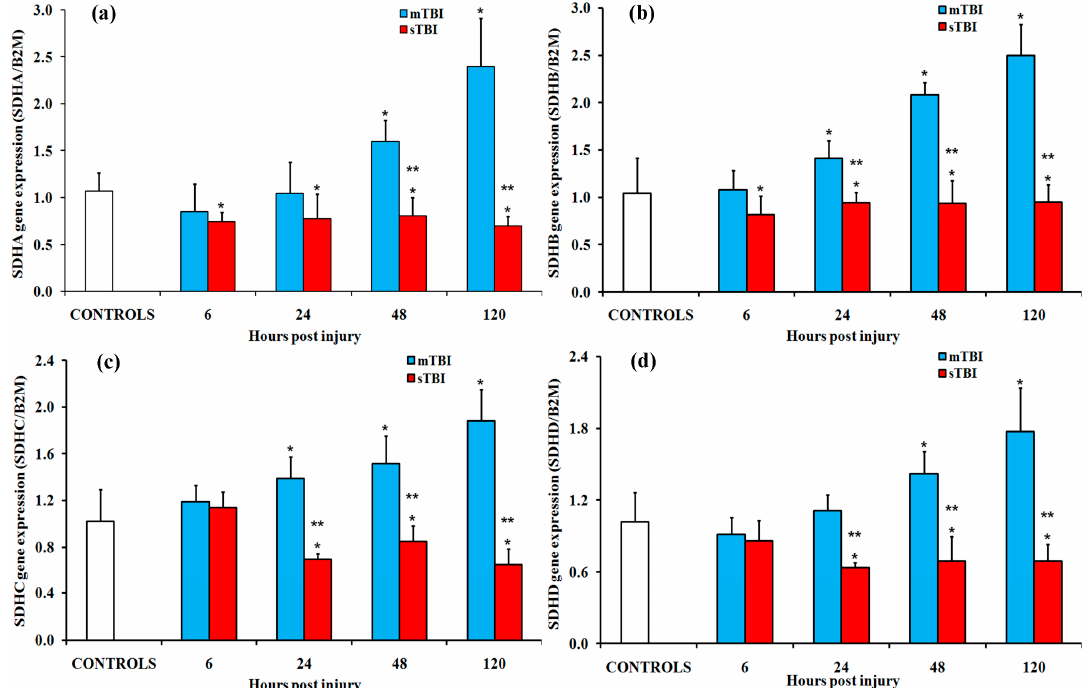
Figure 8. Changes in the expression of genes encoding for the four subunits of succinate dehydrogenase (SDH), or complex II of the electron transport chain (ETC), in brain tissue homogenates of rats receiving a TBI of different severities (mTBI or sTBI) at various times post-injury. ( a ) SDHA, the gene encoding for the A subunit of succinate dehydrogenase; ( b ) SDHB, the gene encoding for the B subunit of succinate dehydrogenase; ( c ) SDHC, the gene encoding for the C subunit of succinate dehydrogenase; ( d ) SDHD, the gene encoding for the D subunit of succinate dehydrogenase. Values are the mean of six animals. Standard deviations are represented by vertical bars. Gene expressions were calculated relative to the expression of the housekeeping gene β -2-microtubulin (B2M). * significantly different from the controls, p < 0.05. ** significantly different from the corresponding time of the mTBI rats, p < 0.05.